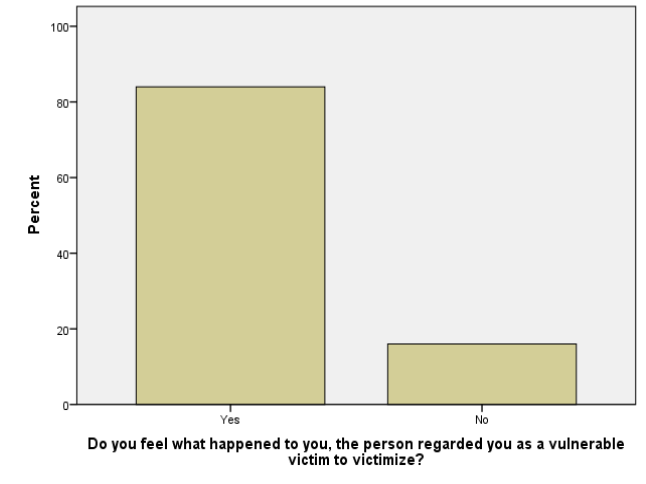
Figure 3: Physically Disabled Children Victimization Due to Their Vulnerability